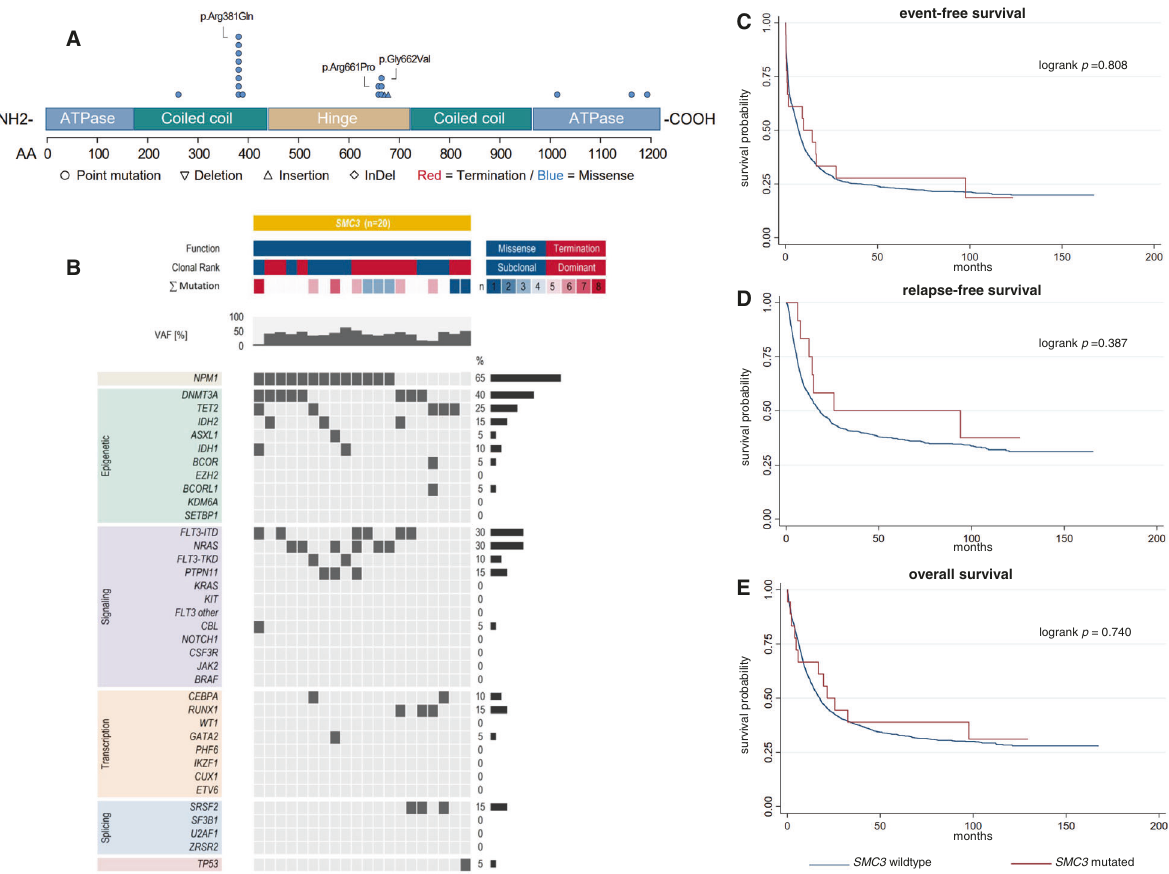
Fig. 4 Distribution, co-mutational spectrum and survival analysis for AML with mutated SMC3 . Graphic representation of the domain structure of SMC3 and positions of SMC3 mutations in 20 AML patients ( A ). Mutations of SMC3 are categorized by function (missense = blue, termination = red), clonal rank (dominant = red/subclonal = blue), number of mutations, and variant allele fraction, and associated co-mutations ( B ). For detailed information on co-mutations and results of individual signi fi cance tests, see Tab. S14. Survival analysis using the Kaplan-Meier method and logrank test for event-free ( C ), relapse-free ( D ) and overall survival ( E ) differentiating between SMC3 -mutated and SMC3 - wildtype